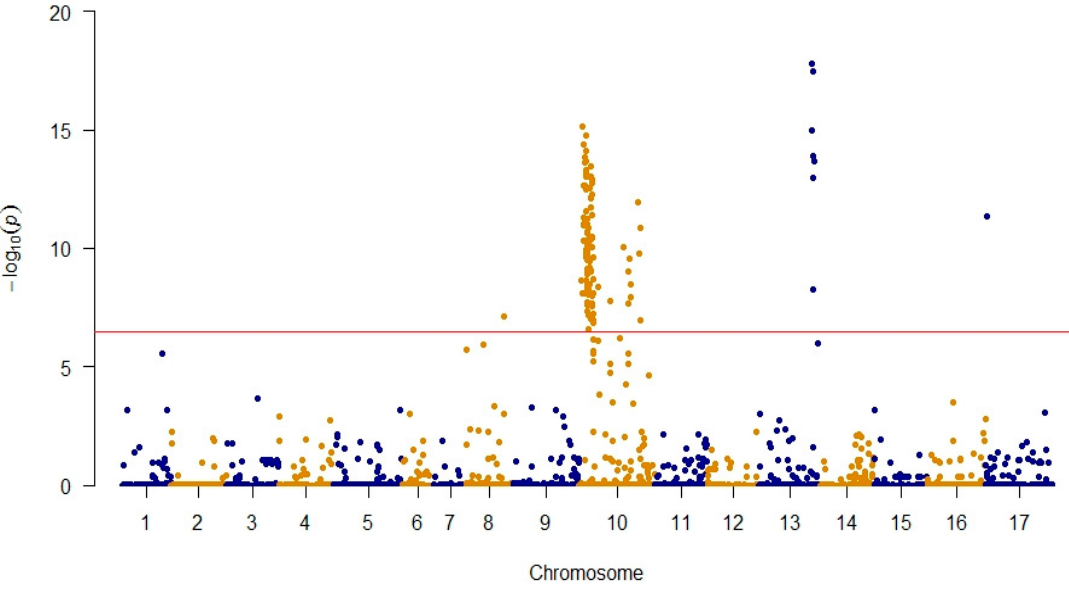
Figure 2. Manhattan plot of associations with the ability to suppress CMS (cytoplasmic male sterility) phenotype. Red line indicates the significance threshold based on the Bonferroni multiple testing correction (alpha = 0.01).